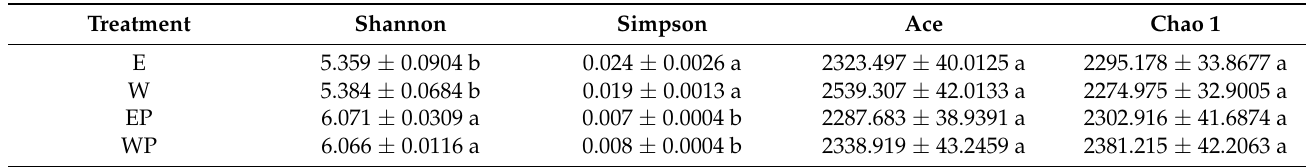
Table 2. Alpha diversity indices of bacterial communities in grapevine replanting soil applied with peanut root exudates.